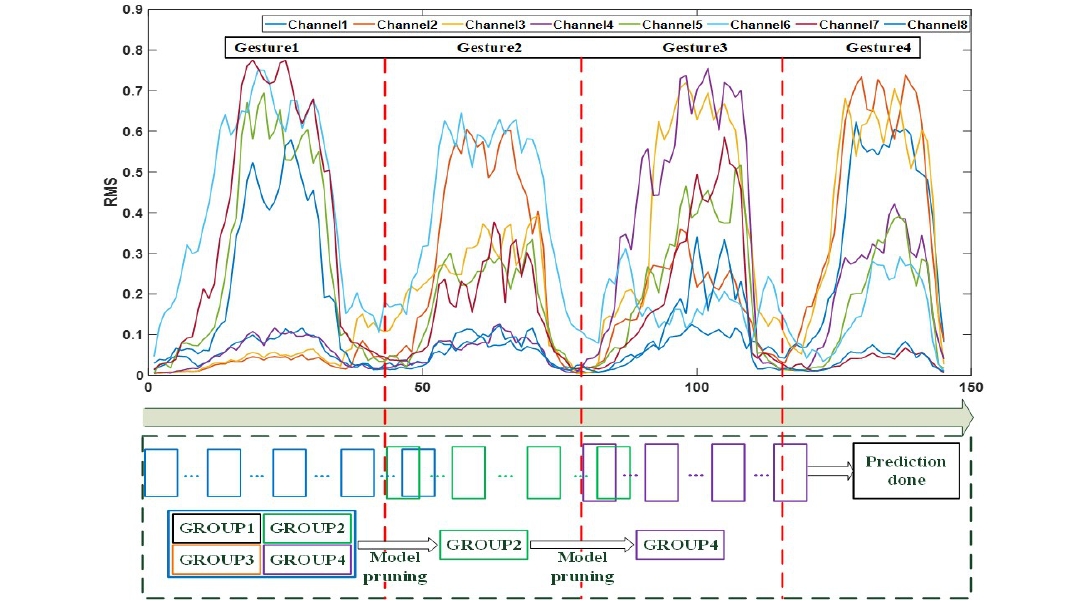
Figure 2. Model pruning with sliding windows on continuous four-hand actions. Every box repre- sents a dynamic sliding window without overlapping. The whole model was divided into 4 groups, while blue sliding windows used the whole model for prediction. Green and purple sliding windows used GROUP2 and GROUP4 for prediction, respectively. The red dotted line represents the starting point of the new hand gesture, which can be used for updating the new starting point of the sliding window in model